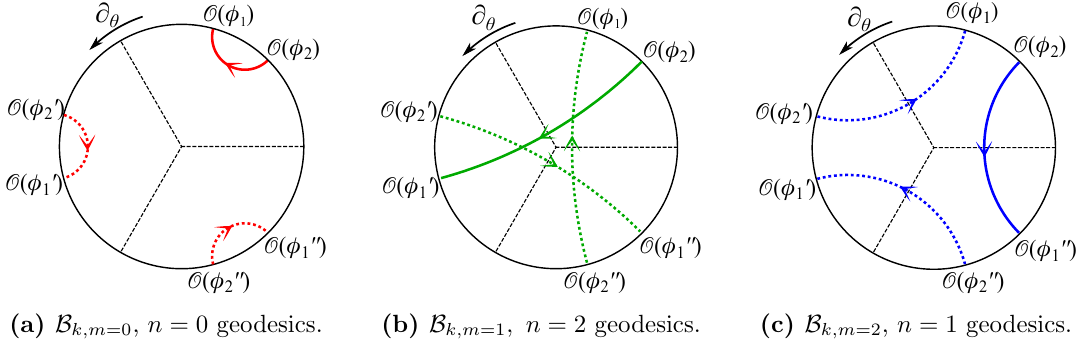
Figure 5 . (a){(c) The contributions to the base OPE from symmetrized pairs of operators at (cid:12)xed angular separation in the covering CFT are encapsulated in the B k;m blocks. The corresponding oriented bulk geodesics are displayed to show the pairings. Note that only two operators are inserted on the boundary at a time, but all image locations are displayed here for